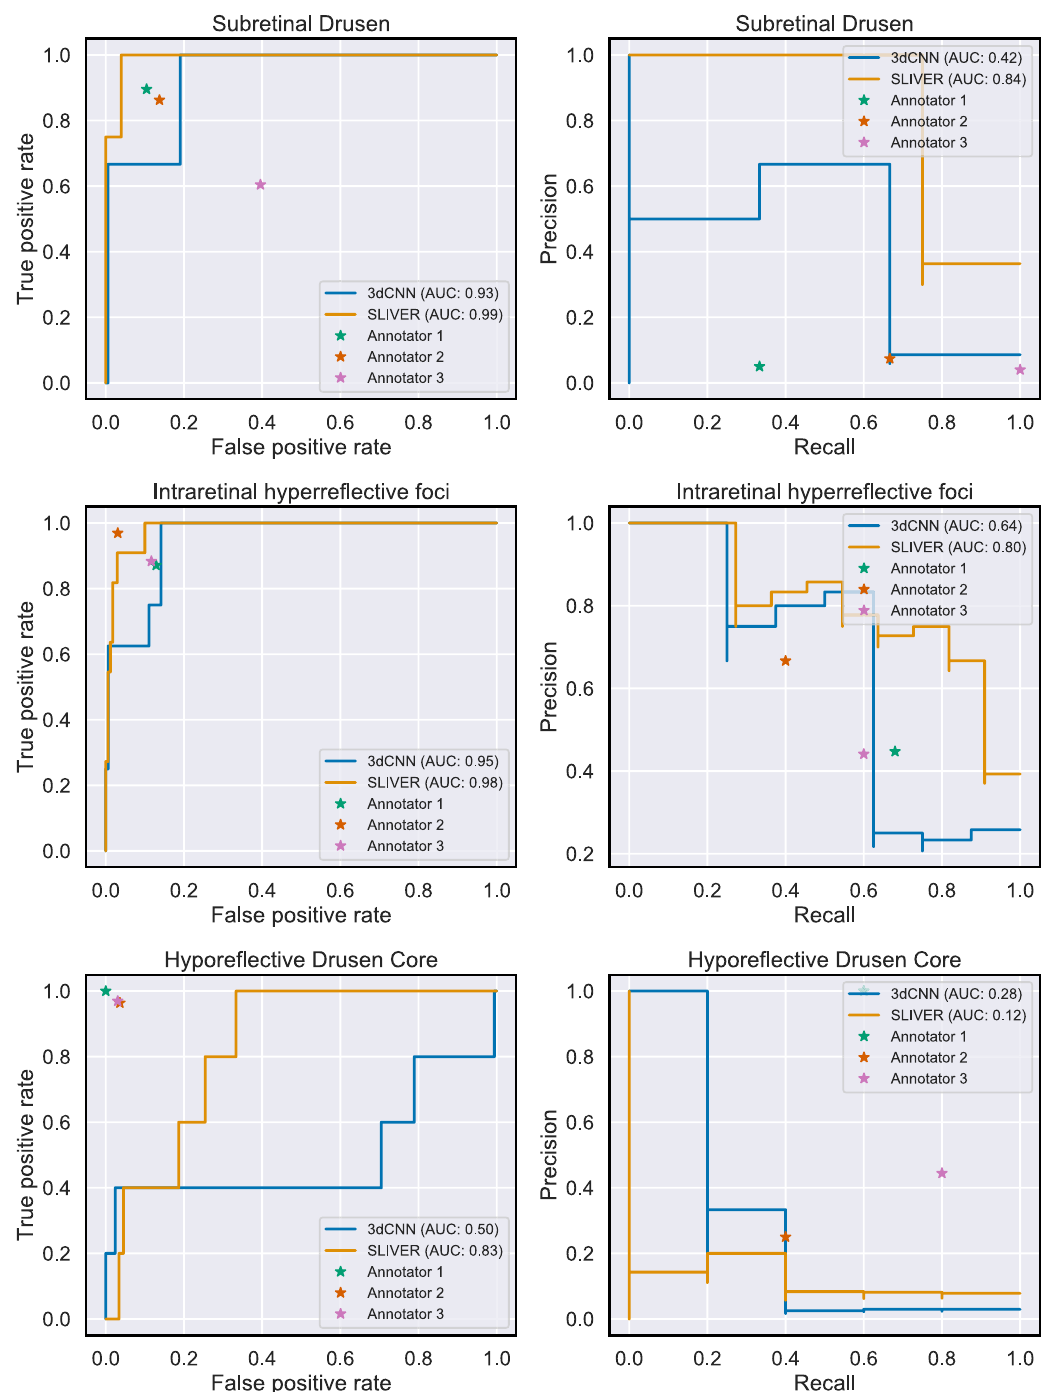
Fig. 2 Comparison of model with clinicians. Our model identi fi ed three biomarkers that were annotated by clinicians. We present ROC (left column) and precision-recall (right column) curves for SLIVER-net and the baseline 3d CNN model along with individual annotator performance. For subretinal drusenoid deposits, SLIVER-net appears to outperform retina fellows in terms of both AUC and precision-recall, while the reverse is true for hypore fl ective drusen